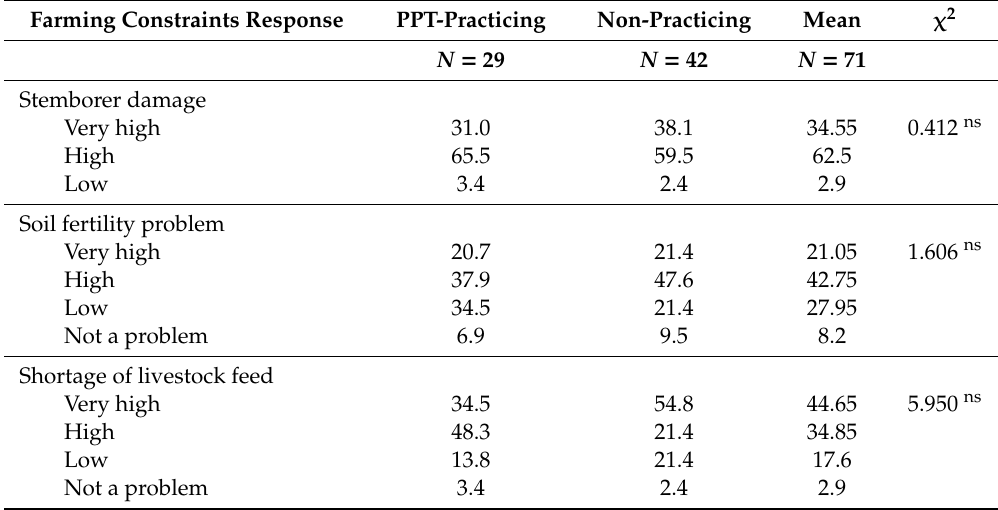
Table 2. Farmers’ perception of farming constraints in the Hawassa district, Ethiopia. Farming Constraints